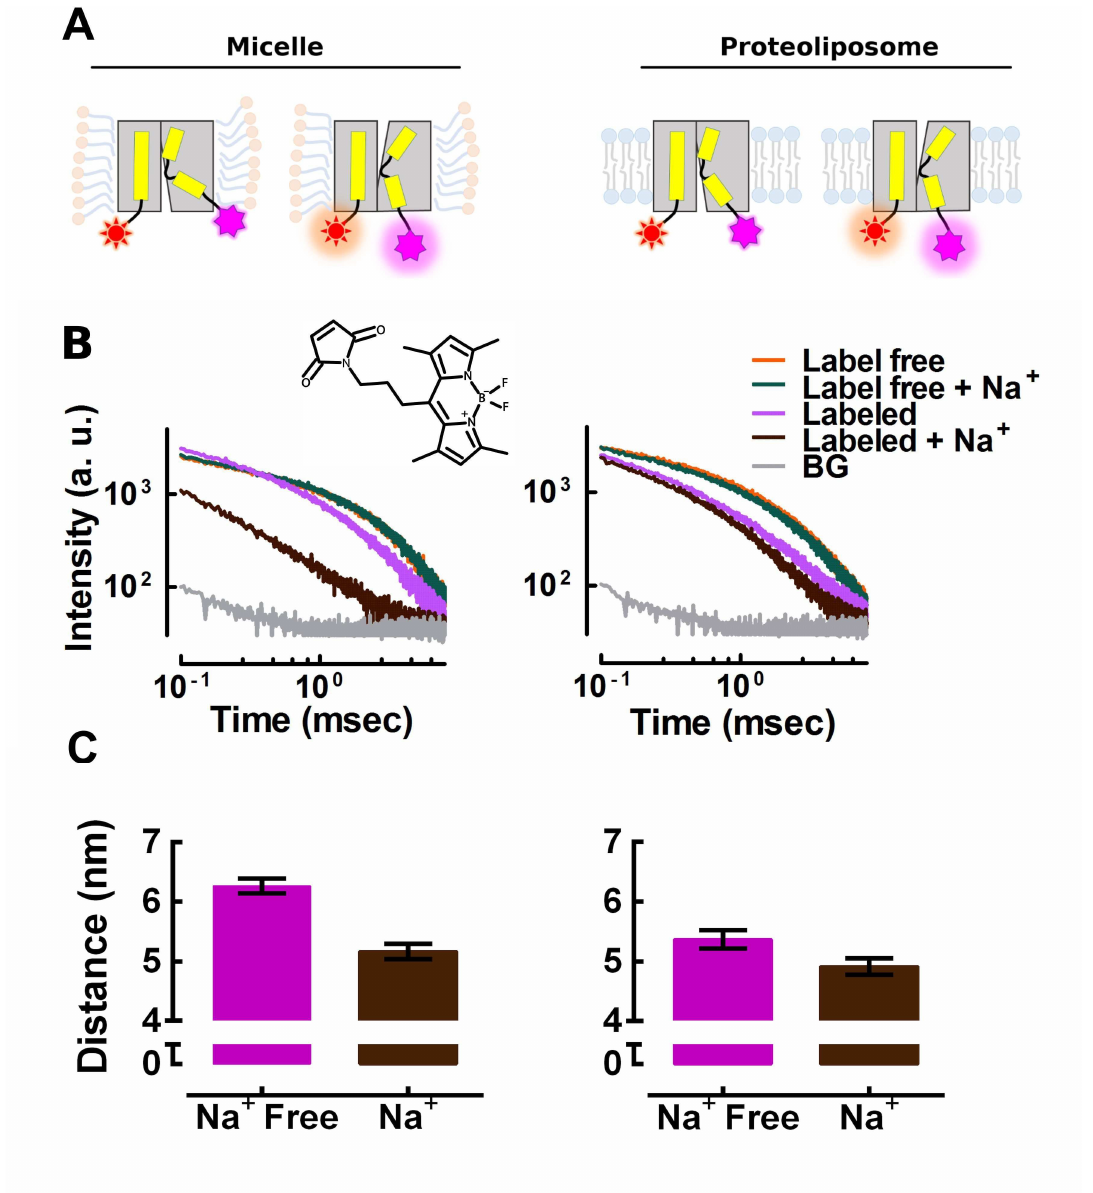
Fig 5. LRET based distance measurements. (A) Schematic renderingof the LRET experiment. The Tb +3 donor is in complex with the LBT tag (red) inserted at the C-terminus; the BODIPY-C3-M acceptor dye (magenta) is chemically linked to residue 9 at the N-cap motif TM1A. (B) Representative Tb +3 decay traces either incorporated into micellesor reconstituted into proteoliposomes, either unlabeledor labeledwith the BODIPY-C3-M acceptor dye, in the presence of 200 mM Na + or Na + free. The structure of BODIPY-C3-M is shown in the insert. (C) Distances calculatedfrom the donor decay between the Tb +3 and the acceptor dye. Shown are means ± S.E.M. from three independent experiments done in